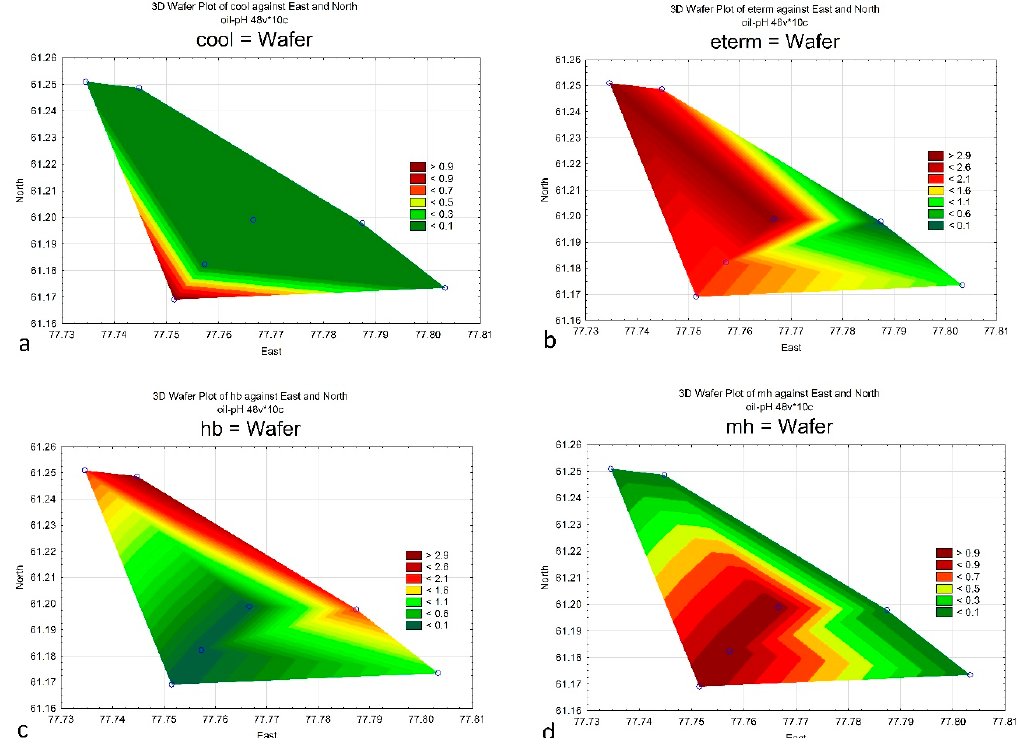
Figure 5. Distribution maps for species indicators of cool water ( a ), eurythermic water ( b ), halophobes ( c ), and mesohalobes ( d ) in seven studied sites of the bogs of the Ershov oil field in the Vakh River basin of the KMAO-Yugra.